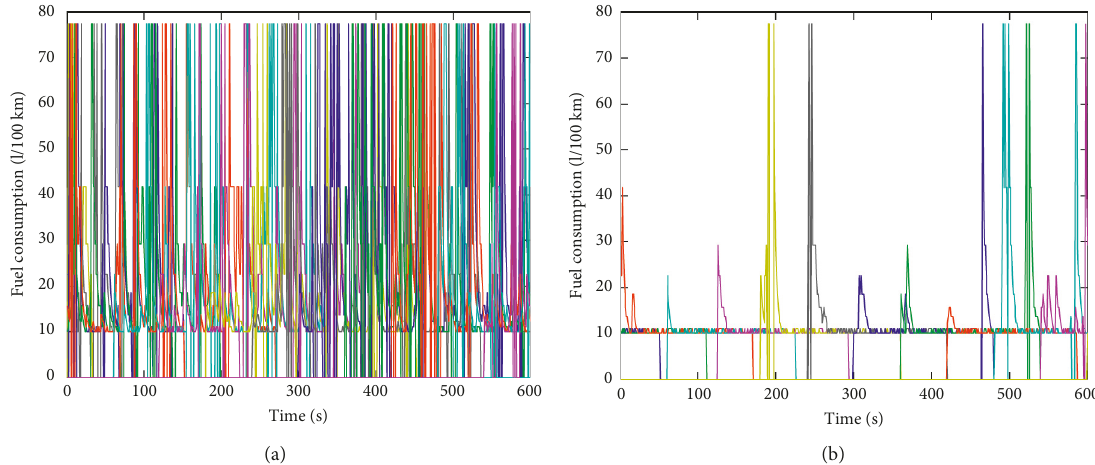
Figure 10: Average bus fuel consumption. (a) Average bus fuel consumption in Group A. (b) Average bus fuel consumption in Group